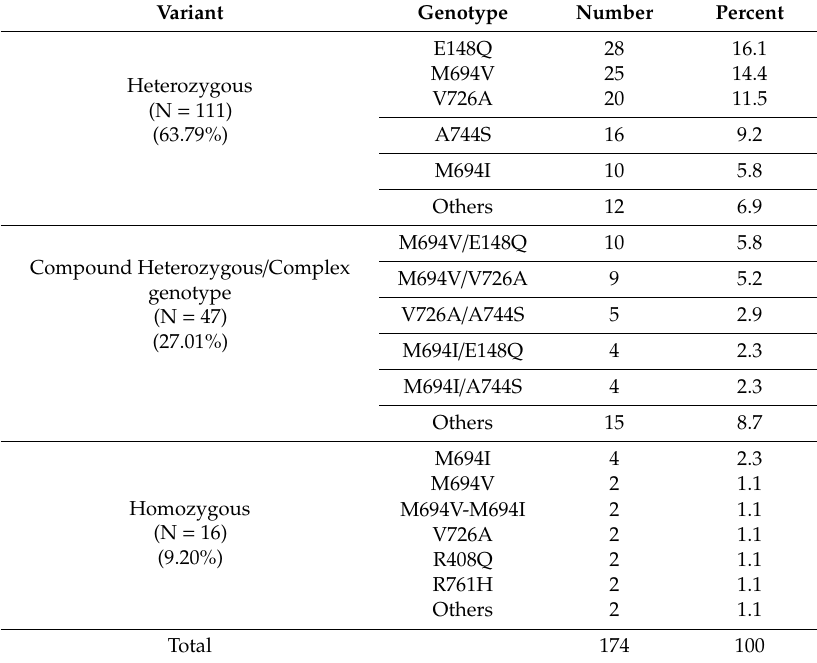
Table 4. Frequency of the most common MEFV variants and genotypes of Familial Mediterranean Fever (FMF)